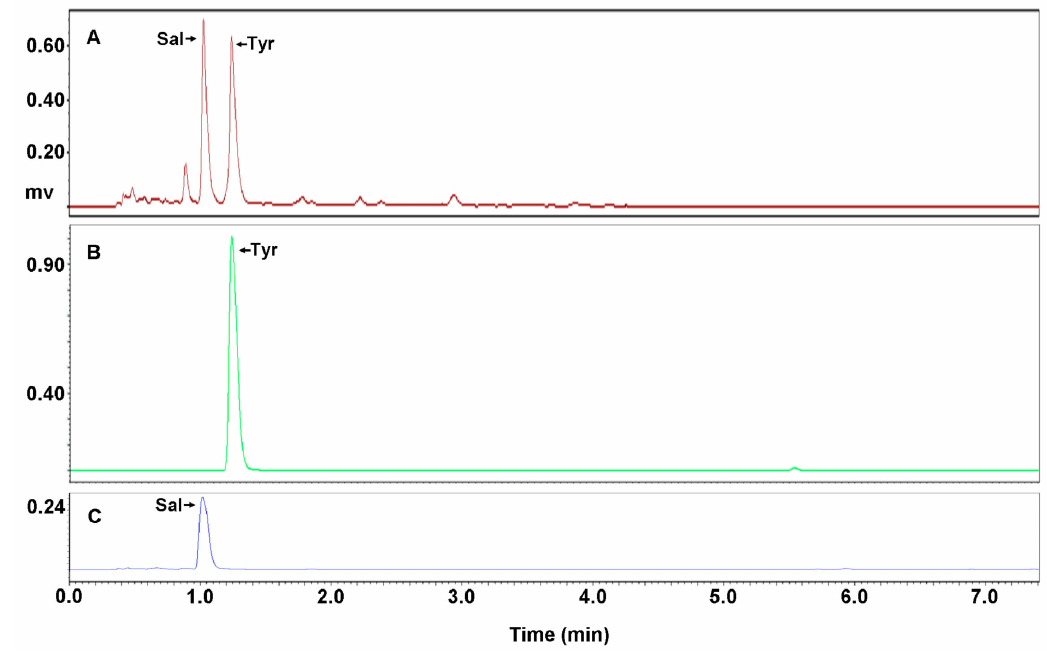
Figure 6. UPLC profile for isolation by silica column chromatography. Shown in sequence are profiles of fraction enriching salidroside and p -tyrosol (i.e., FEST) ( A ), p -tyrosol ( B ), and salidroside ( C ). Ordinates were proportionally adjusted for comparison. Sal and Tyr refer to salidroside and p -tyrosol, respectively. Table 3. The effect of silica column chromatography on isolation of salidroside and p